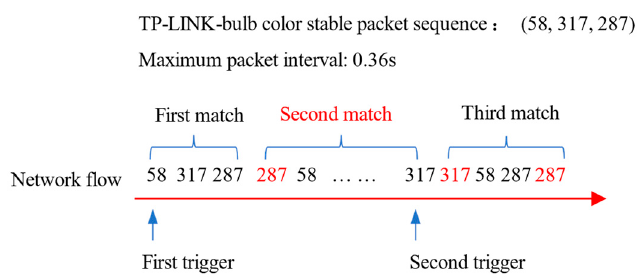
Figure 5. Signature detection process in DESEND+.